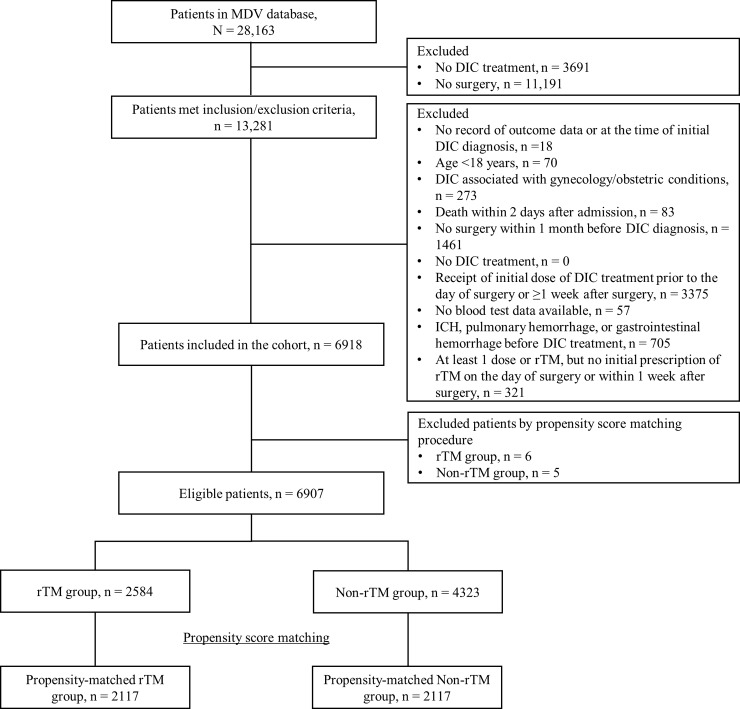
Flow diagram illustrating patient enrollment (all types of surgery).MDV, Medical Datavision; DIC, disseminated intravascular coagulation; rTM, recombinant thrombomodulin; ICH, intracranial hemorrhage.